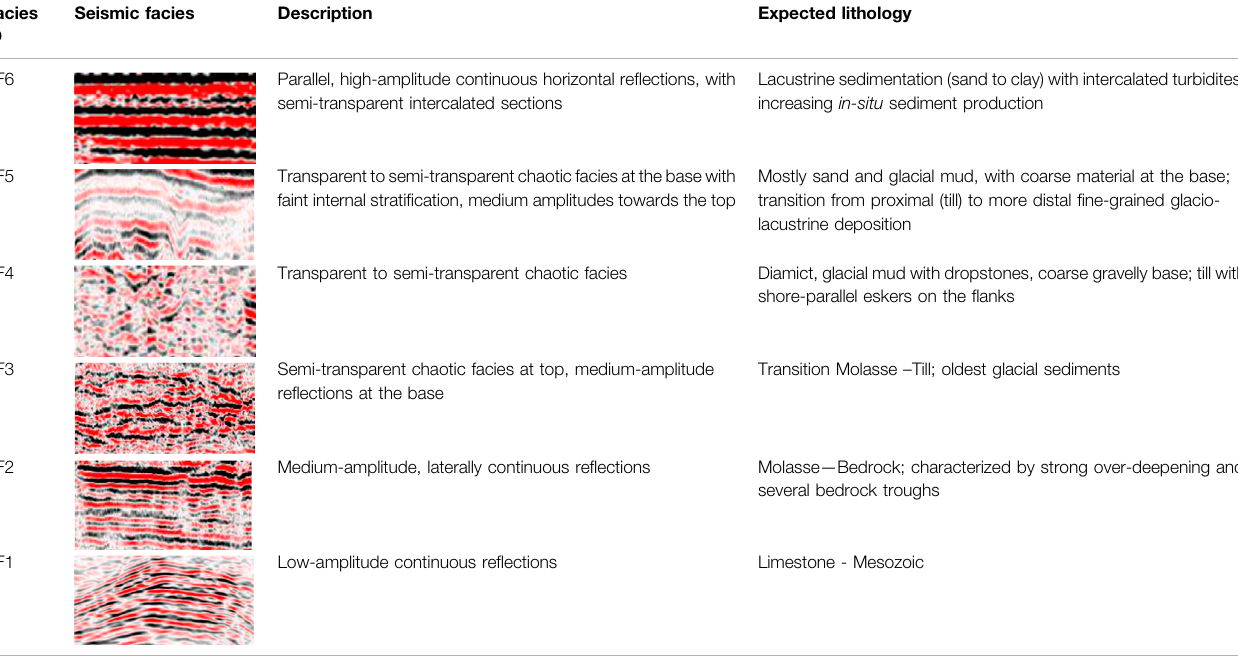
TABLE 1 | Overview of seismic facies, expected lithology and interpretation. Facies Seismic ID